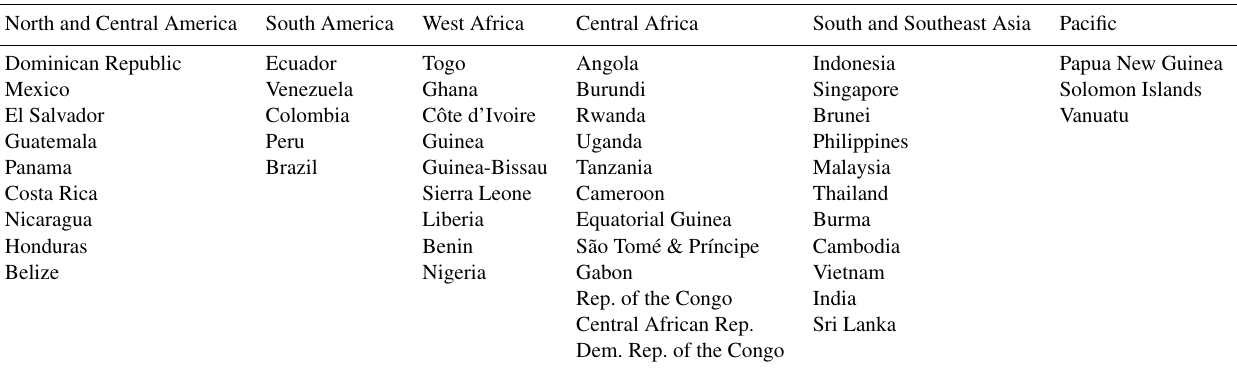
Table A2. List of countries where we confirmed the presence of oil palm plantations with the global oil palm layer for the second half of